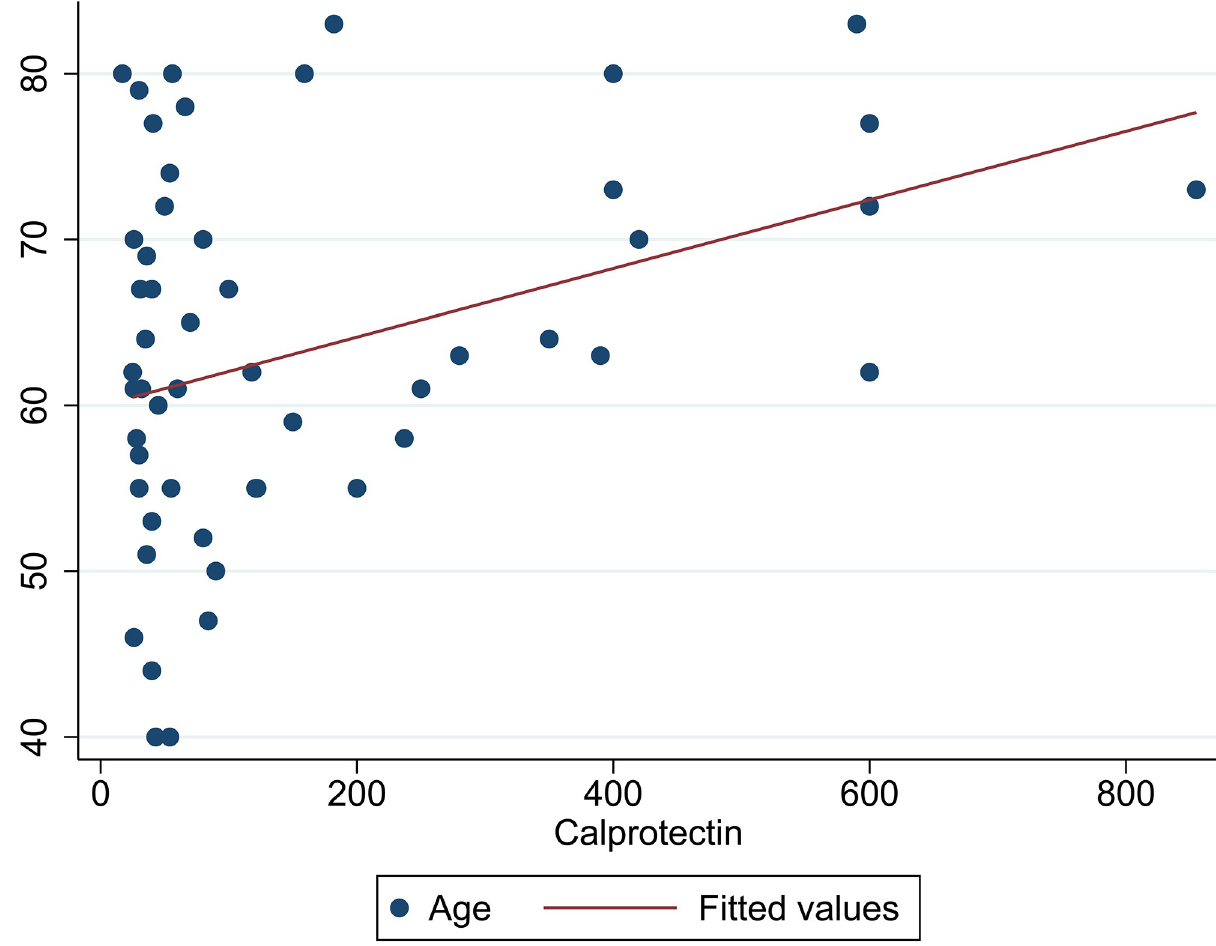
Fig 2. The correlation of age and CP among patients with MM (n =